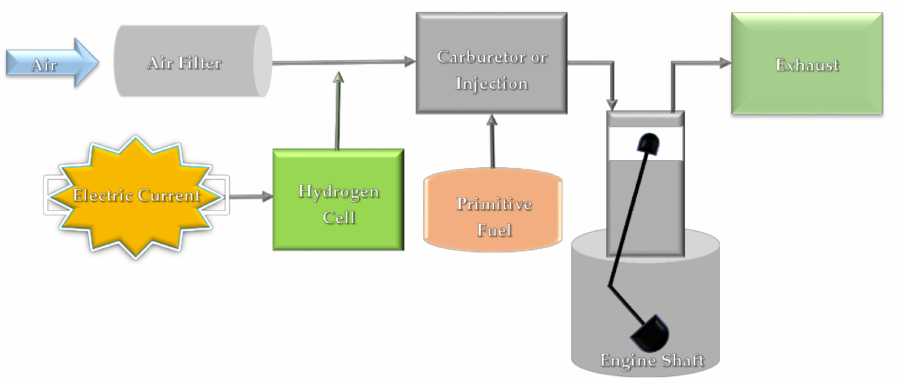
Figure 2. Schematic of hydrogen cell in an internal combustion engine. Adapted from Al-Rousan [31]. Hydrogen has the greatest quantity of energy per unit mass of all fuels, which means that 1 g of H has the same quantity of energy as 2.8 g of gasoline. When cooled until reaching its liquid state, this low molecular mass fuel occupies a volume 700 times smaller than what it occupies in the gas state. Its density (0.08967 kg/m 3 ) is 14.4-fold less than that of air (1.2928 kg/m 3 )